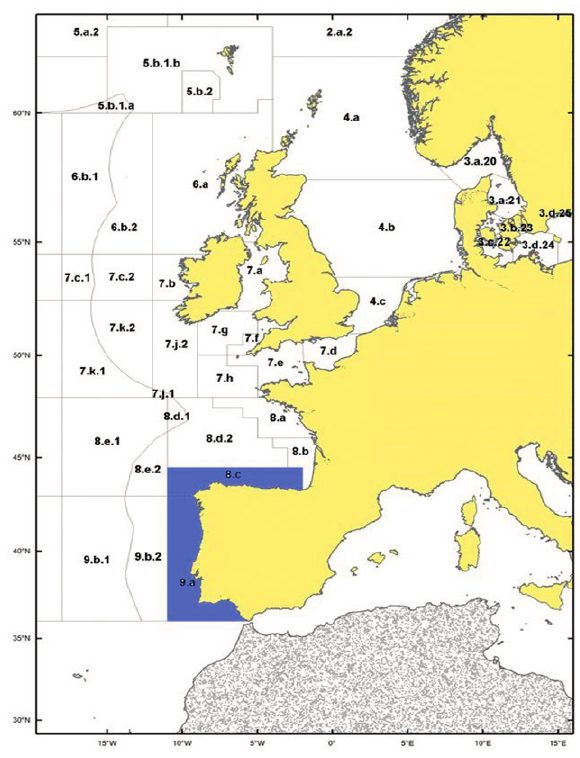
Fig. 3. – The southern Iberian hake stock includes ICES subareas 8c and 9a (in